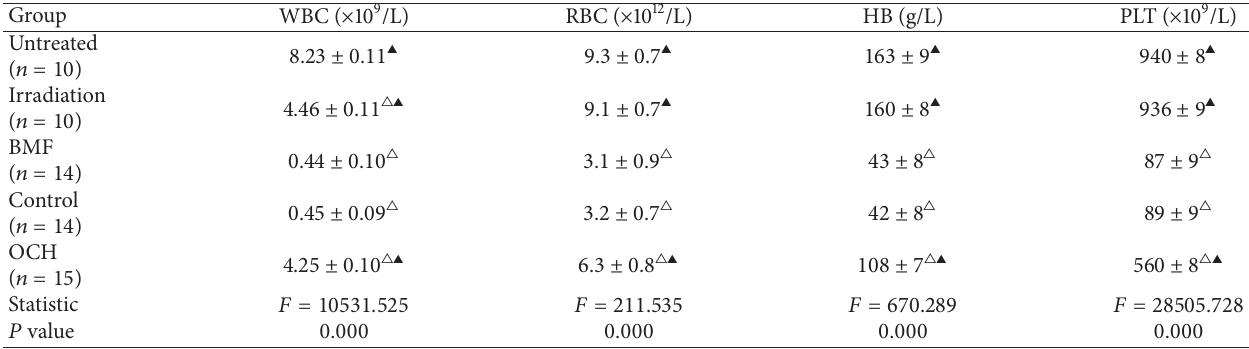
Table 4: Complete blood cell count on d14 after treatment.